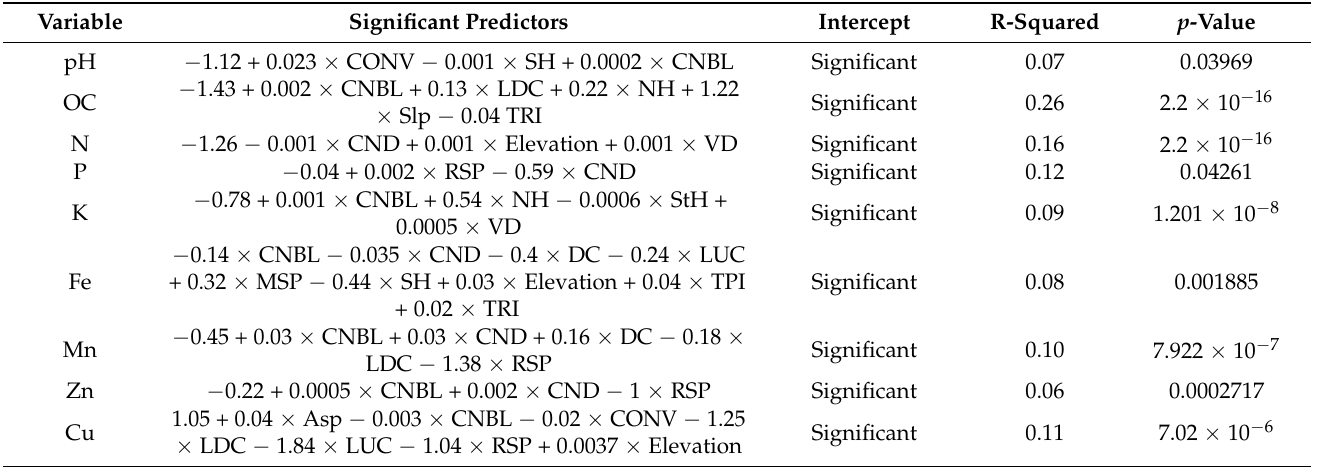
Table 4. Results of the stepwise multiple linear regression model relating soil properties to environ- mental covariates.